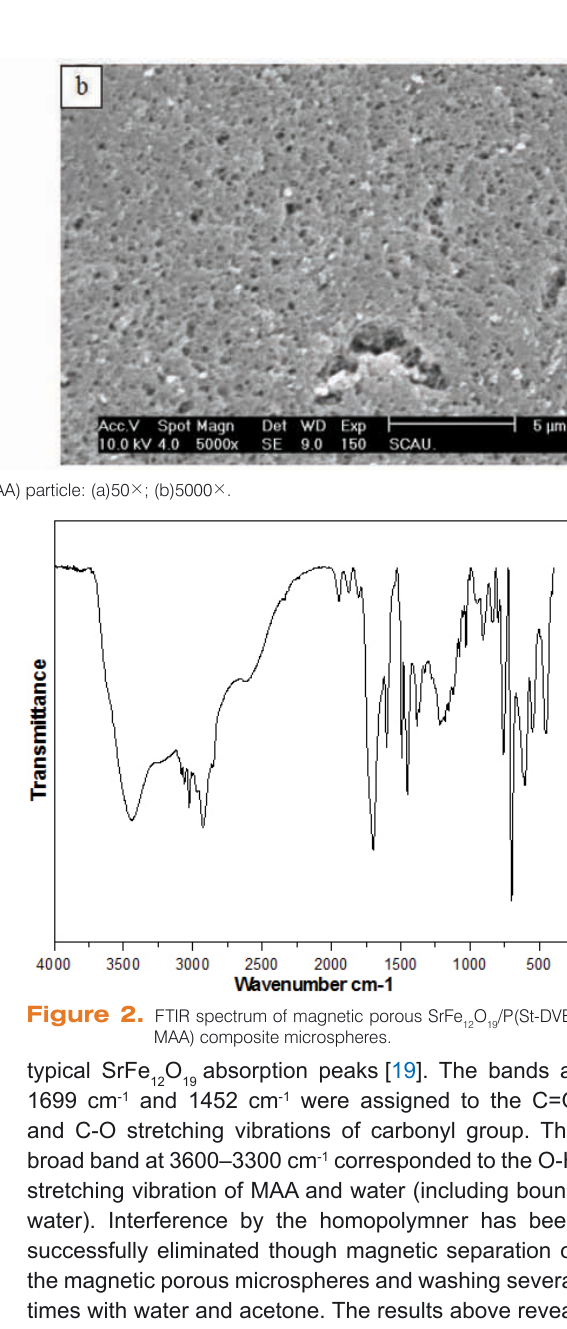
Figure 2. FTIR spectrum of magnetic porous SrFe MAA) composite